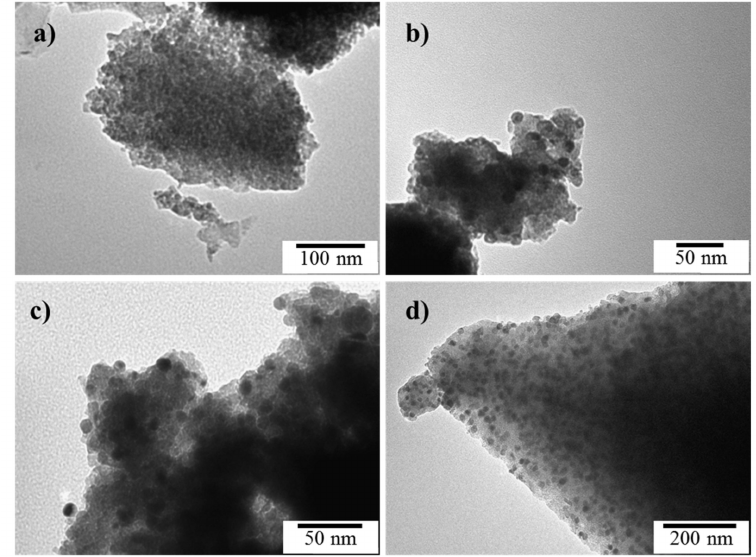
Figure 3. TEM micrographs of calcined and reduced samples: ( a ) TiO 2 / SiO 2 , ( b ) TiO 2 / SiO 2 / Pd5—H 2 , ( c ) TiO 2 / SiO 2 / Pd12-H 2 and ( d ) TiO 2 / SiO 2 /